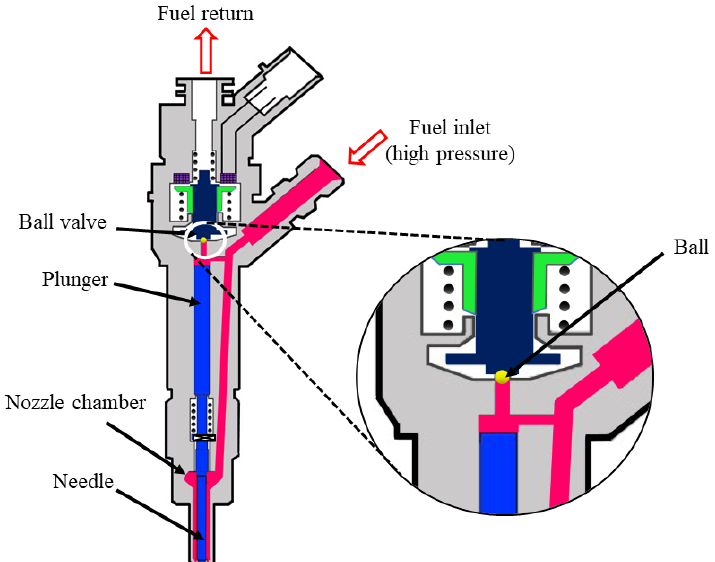
Figure 4. Lateral view of a CRD engine injector [26].